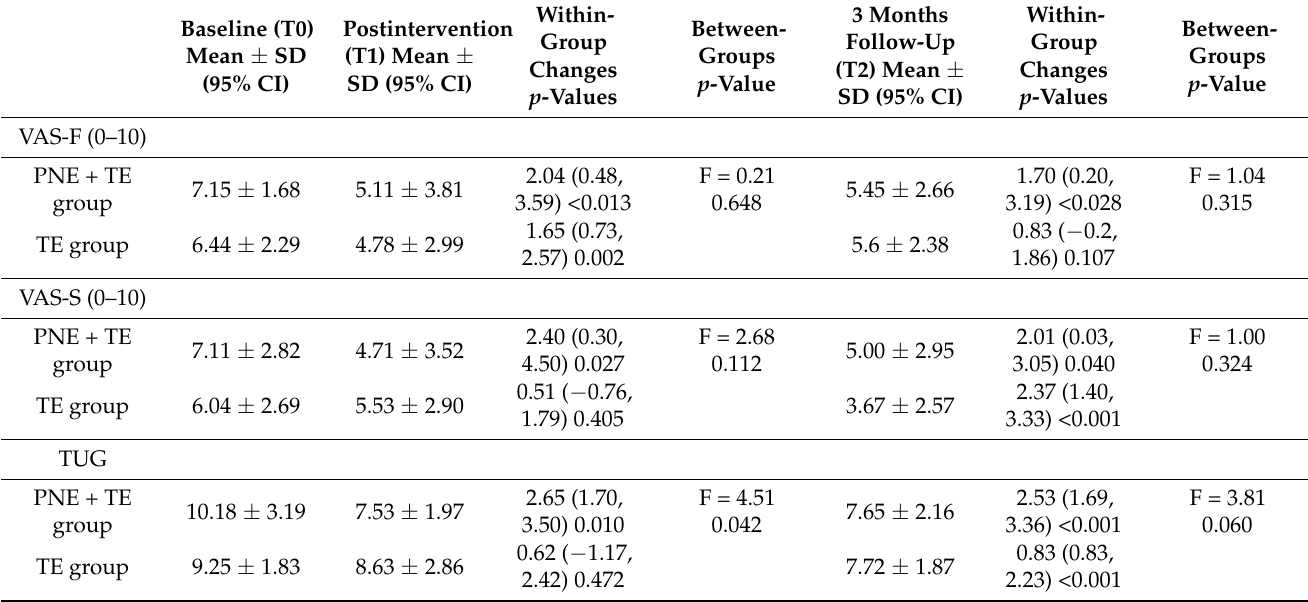
Table 2. Descriptive data, between-groups and within-group statistical significance, and score changes on ITT